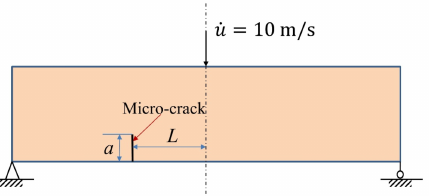
Figure 5. Schematic diagram of a three-point bending beam with a pre-existing micro-crack.